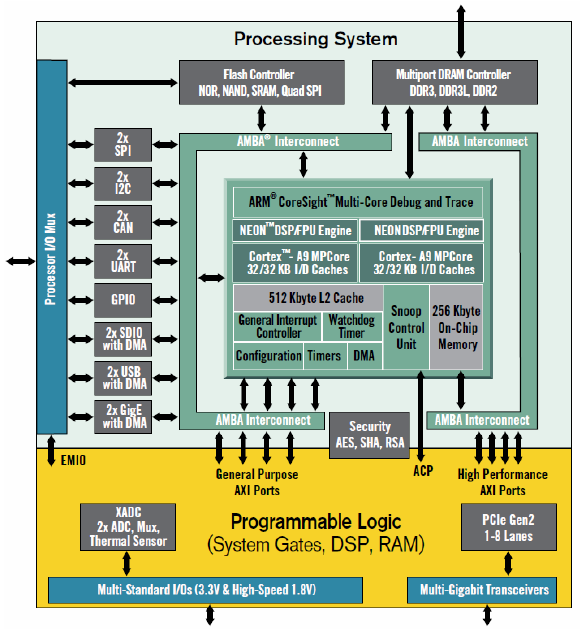
Figure 6: Zynq-7000 all programmable SoC block